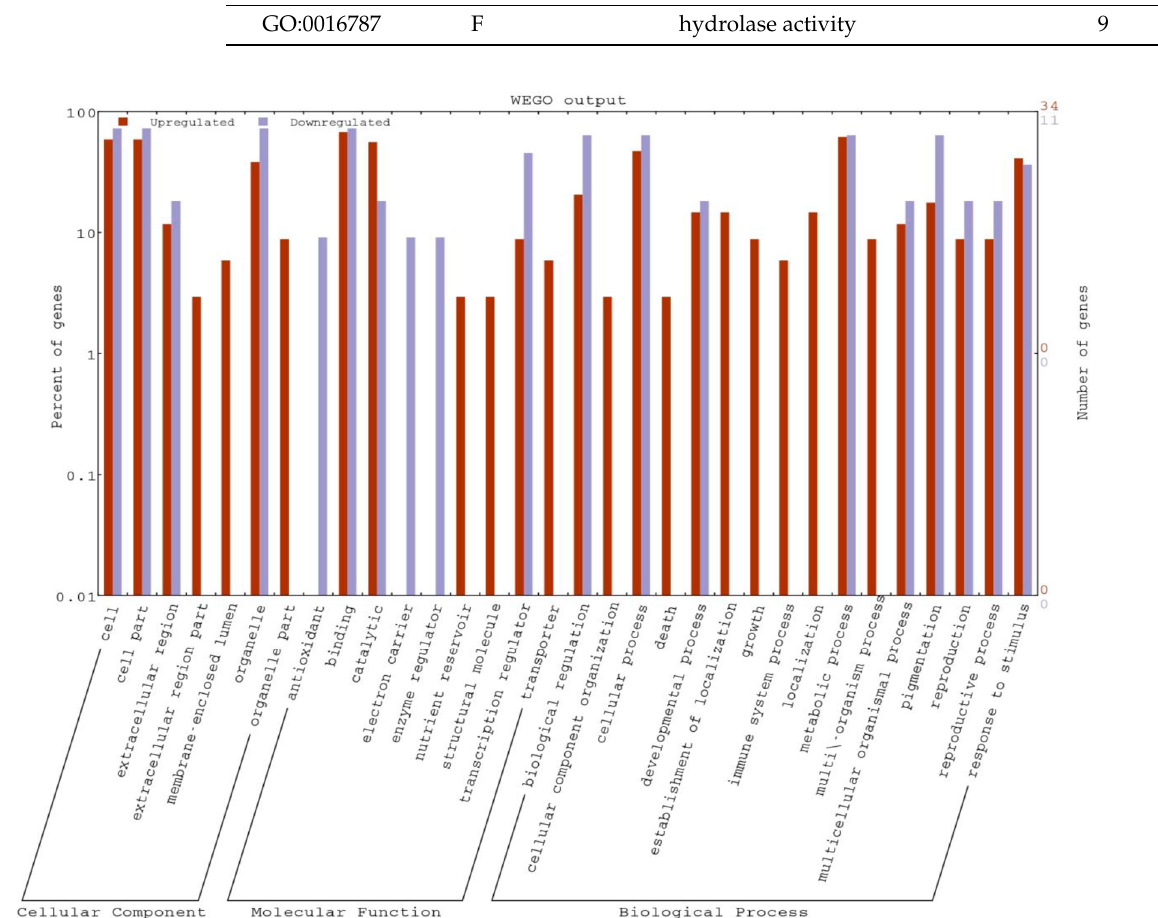
Figure 4. Representation of differentially expressed genes (DEGs) in a WEGO plot. In total, 392 GO terms were significantly expressed in both genotypes (Table S2). Im- portantly, two significant GO terms, involved in responses to stimulus (GO: 0050896)